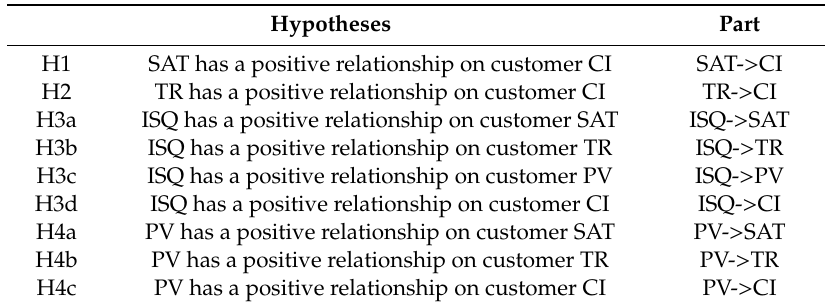
Table 1. Relationship